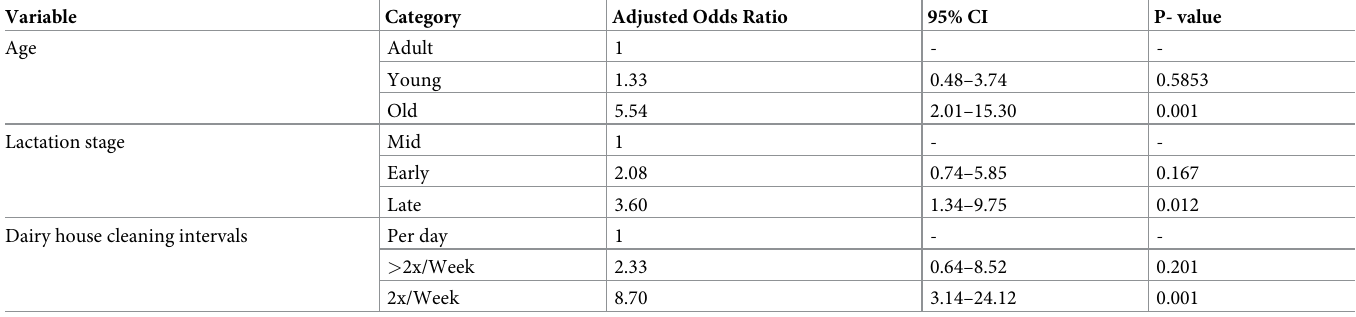
Table 7. The best-fitting model for predictors of S . aureus isolation from milk in the study area.